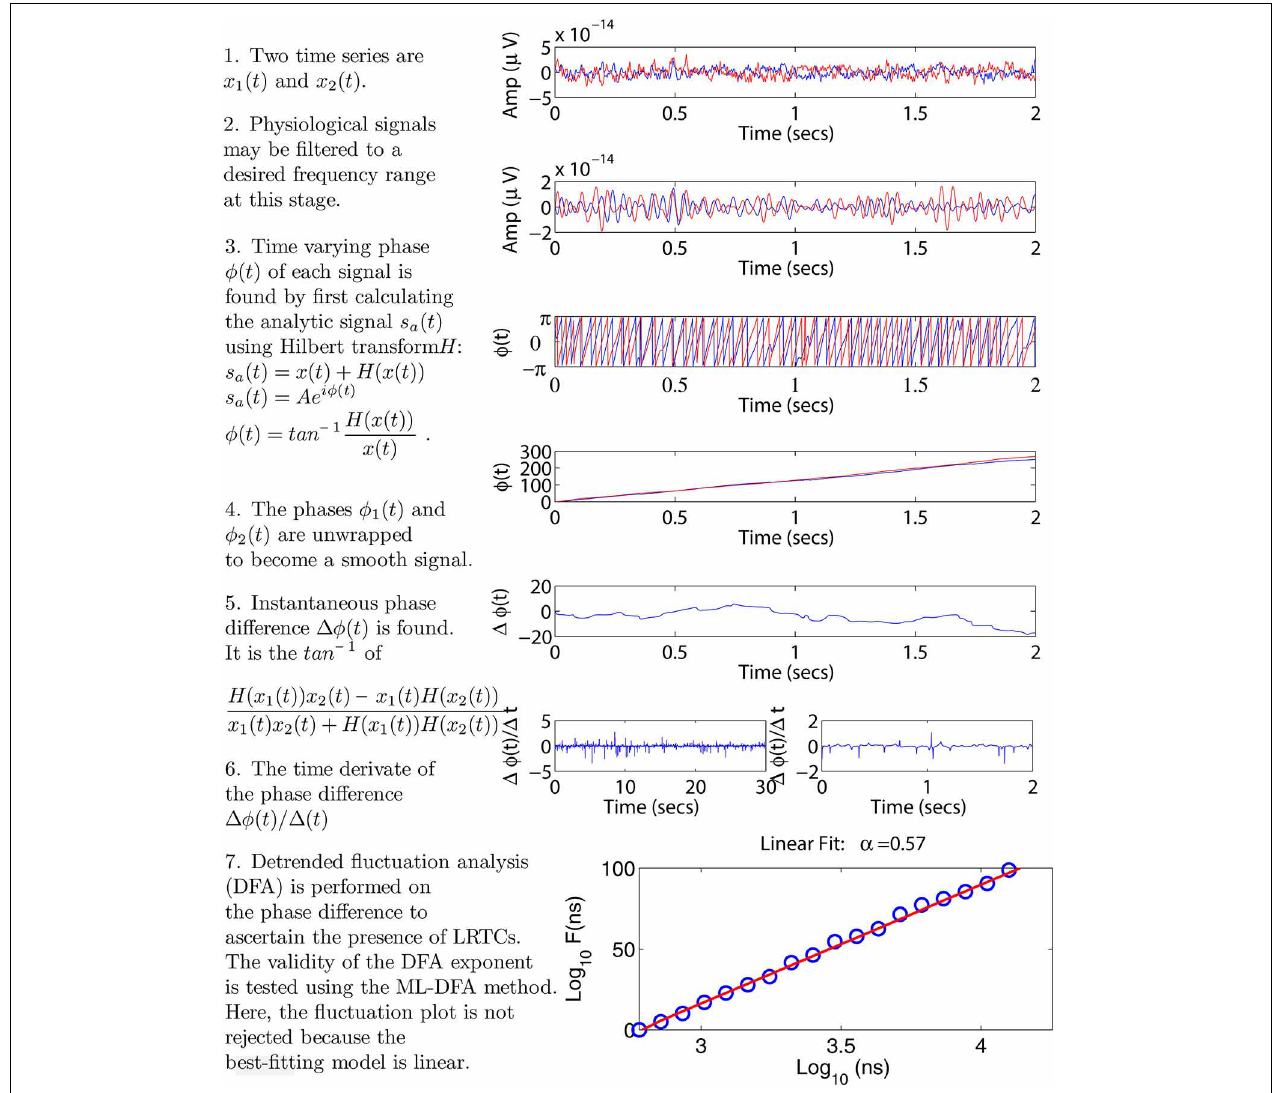
FIGURE 1 | Step-by-step illustration of the proposed method. We use two sample MEG signals from the left and right motor cortex, displayed throughout panels 1–4 in red and blue, respectively. Panel 2 shows an optional bandpass filtering step. In panel 3 the instantaneous phases of the two time series are calculated using the Hilbert transform. Panel 4 shows the unwrapped phases leading to a time-varying phase difference displayed in panel 5. In panel 6, the rate of change of this phase